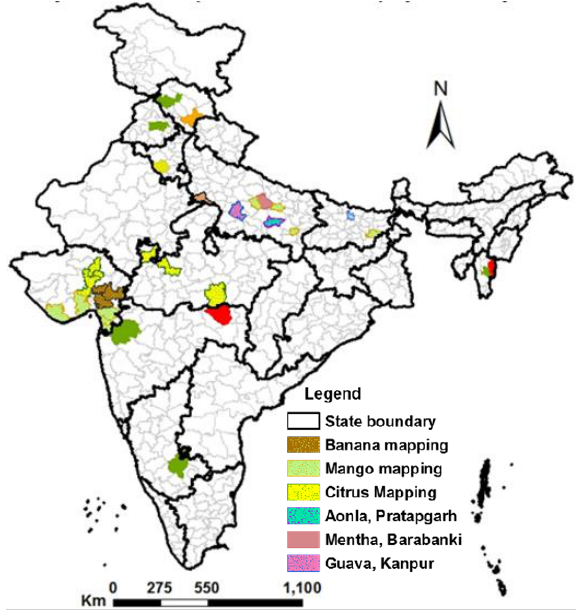
Figure 1: Distribution of study districts for different crops The State Remote Sensing Applications Centres in collaboration with SAC have also made the complete horticulture crop mapping in different districts (states) Viz. Nashik (Maharashtra), Kangra (Himachal Pradesh), Agar & Shajapur (MP), Serchip (Mizorum), Tumkur (Karnataka) and Ludhiyana (Punjab) in India (Table 1, Figure 1). Out of all these